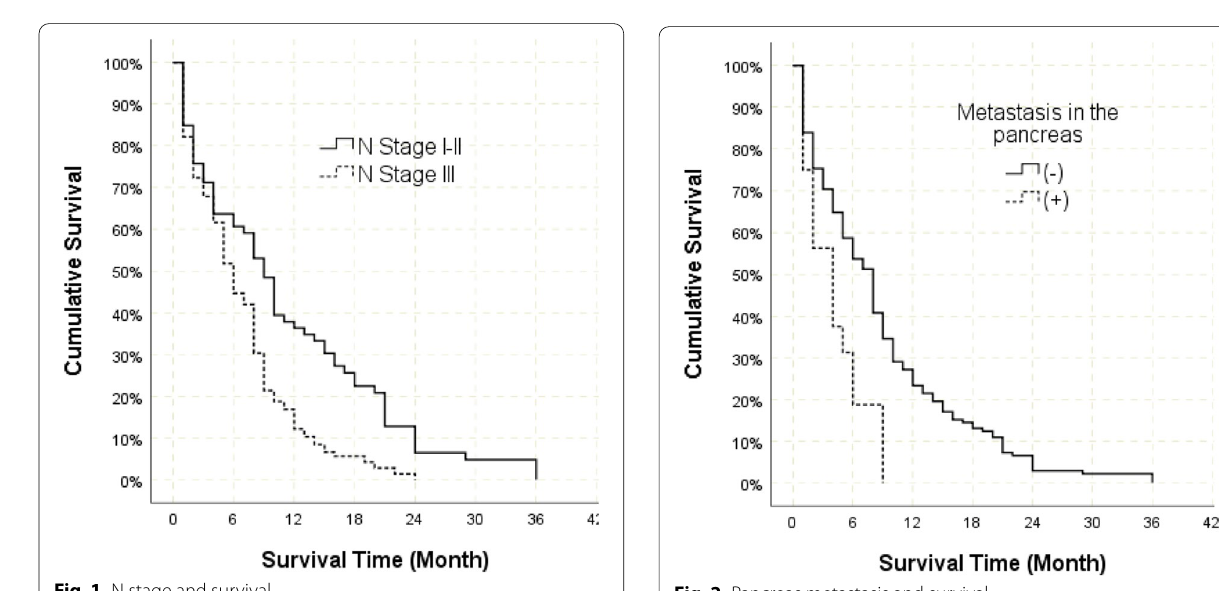
COX regression (forward LR) Data in bold and italic indicate significant values: p < 0.05